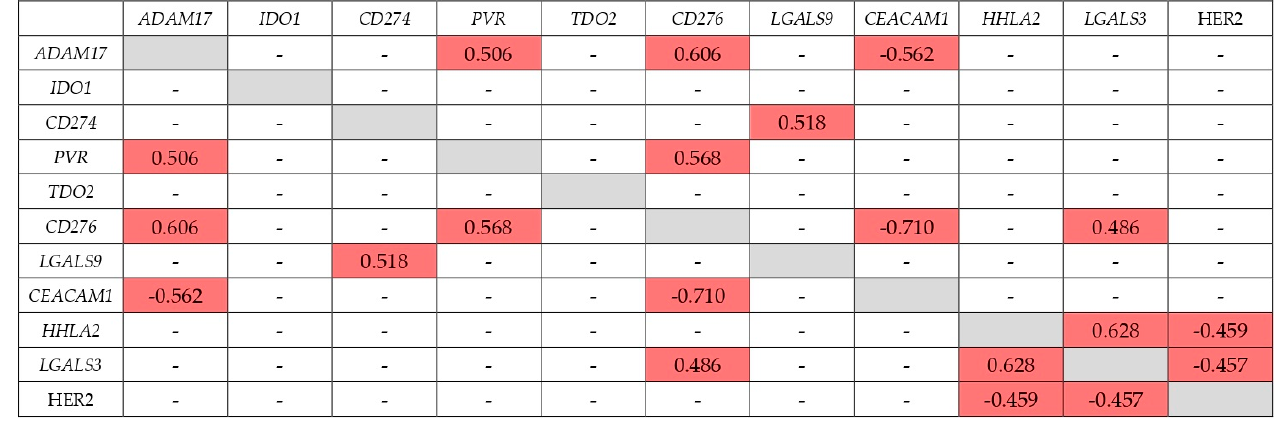
Figure 3. Correlation of expression at stage IV (metastatic GC). significant correlation; there is